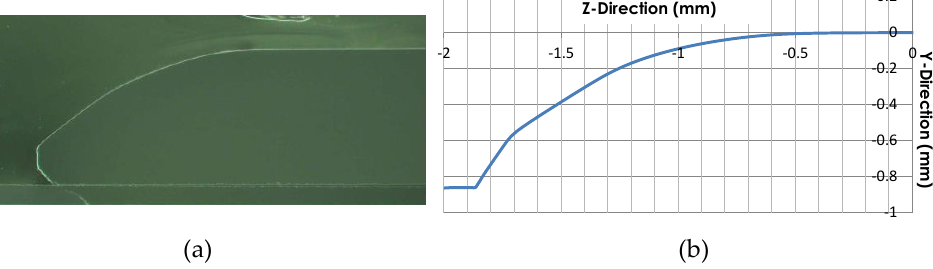
Figure 8. ( a ) Cross-sectional view of reflection surface 1 of the cover glass. ( b ) Using UA3P measurement results, the angle of reflection surface 1 is 39.09 degrees.